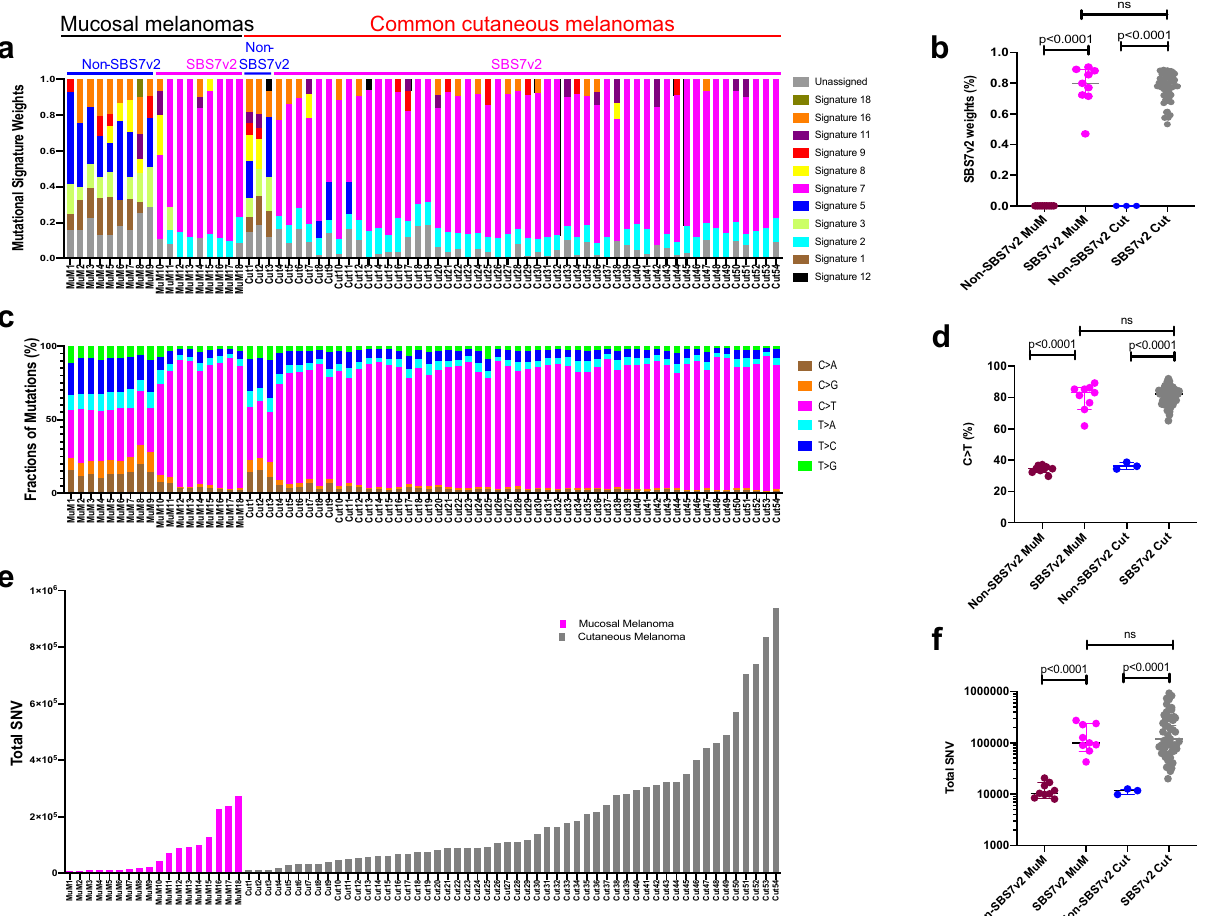
Fig. 1 Mutation spectra in mucosal and common cutaneous melanomas. a Mutation signatures weighted by relative contribution to spectrum of mutations in individual tumor genomes. Indices above indicate mucosal (black, n = 18) or common cutaneous (red, n = 54) melanomas with subdivision into non-SBS7v2 (blue, n = 9, n = 3, respectively) and SBS7v2 (magenta, n = 9, n = 51 respectively) genomes. Columns represent individual tumors. b Relative contribution of SBS7v2 to mutation spectra (SBS7v2 Weights) for individual mucosal (MuM) or cutaneous (Cut) melanomas with SBS7v2 (magenta n = 9, gray n = 51) or non-SBSv2 (maroon n = 9, blue n = 3) genomes. c Proportion of six nucleotide transitions/transversions for individual tumor genomes (individual columns). d Proportions of C > T nucleotide transitions in individual mucosal (MuM) or cutaneous (Cut) melanomas with SBS7v2-dominant (magenta n = 9, gray n = 51) or non-SBSv2 (maroon n = 9, blue n = 3) genomes. e Total SNVs in individual mucosal (MuM, magenta, n = 18) or cutaneous (Cut, gray, n = 54) melanomas. Columns represent individual tumors. f Total SNVs in mucosal (MuM) and cutaneous (Cut) melanomas with SBS7v2-predominant (magenta n = 9, gray n = 54) or non-SBSv2 (maroon n = 9, blue n = 3) genomes. Panels b , d , f show median and 95% con fi dence intervals, dots denote individual tumors, P -values determined by two-tailed Mann – Whitney U , ns = not signi fi cant: 0.4140 in b , 0.8387 in d , 0.6838 in f ,